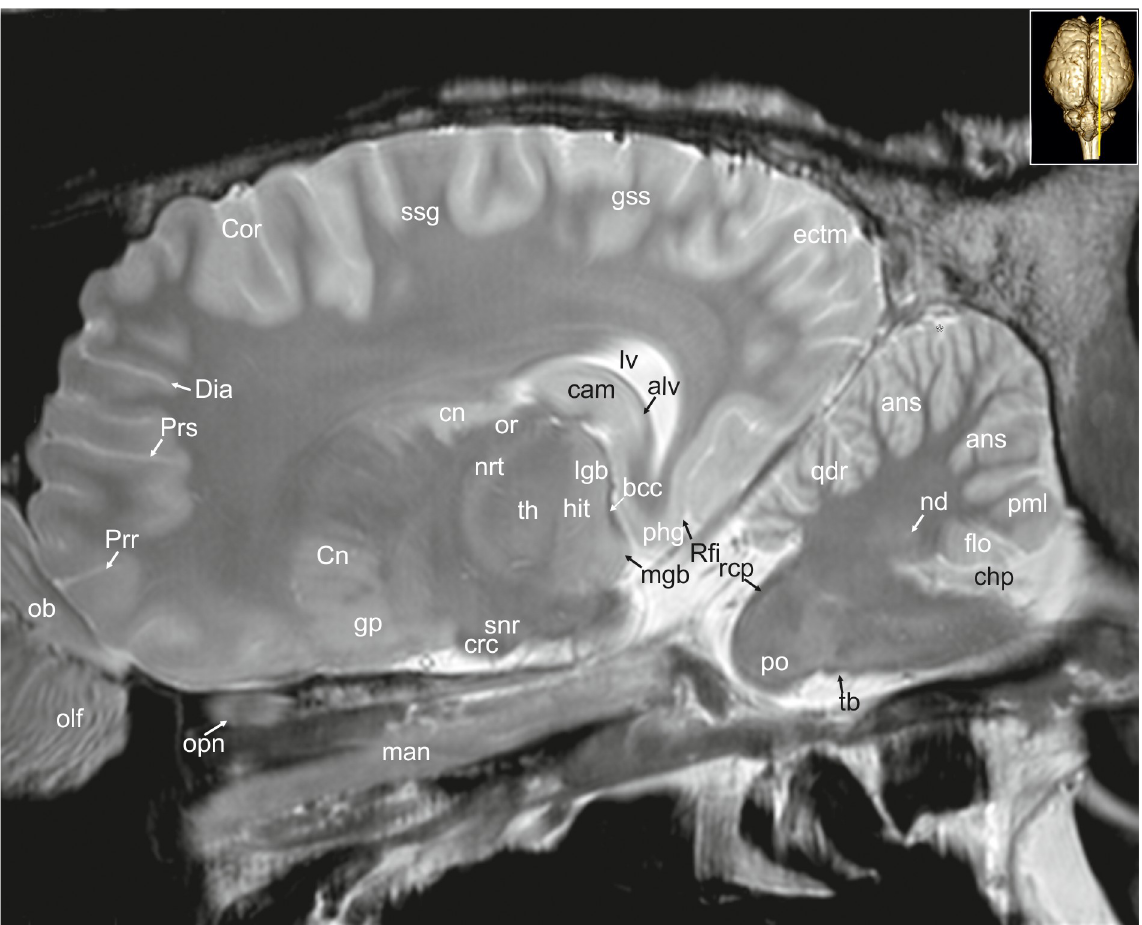
Fig 31. Parasagittal magnetic resonance image of the equine brain at the level of the nucleus reticularis thalami. alv: alveus, ans: ansiform lobule, bcc: brachium of the caudal colliculus, cam: ammon’s horn, chp: choroid plexus, cn: caudate nucleus, Cor: coronal sulcus, crc: cerebral crus, Dia: diagonal sulcus, ectm: ectomarginal gyrus, flo: flocculus, gp: globus pallidus, hit: habenulo-interpeduncular tract, lgb: lateral geniculate body, lv: lateral ventricle, man: mandibular nerve, mgb: medial geniculate body, nd: dentate nucleus, nrt: reticular nucleus of the thalamus, ob: olfactory bulb, olf: olfactory fibres, opn: optic nerve or: optic radiation, phg: parahippocampal gyrus, pml: paramedian lobule, po: pons, Prr: prorean sulcus, Prs: presylvian sulcus, qdr: quadrangulare lobule, rcp: rostral cerebellar peduncle, Rfi: rhinal fissure, snr: substantia nigra, ssg: suprasylvian gyrus, th: thalamus. the horse, the adenohypophysis (Figs 8, 17, 26, 28 and 29: ah), the neurohypophysis (Figs 17 and 26: nh), and the intermediate part (pars intermedia; Figs 26 and 28: psi). The neurohy- pophysis has two visible parts. The distal part forms the bulk of the neurohypophysis extending caudally far beyond the level of the mammillary bodies towards the midbrain [33]. The other part is the elongated infundibular stalk (pars infundibularis; Figs 7, 17 and 26: inf), located in the middle between the two lobes of the adenohypophysis in transverse images. The ventral